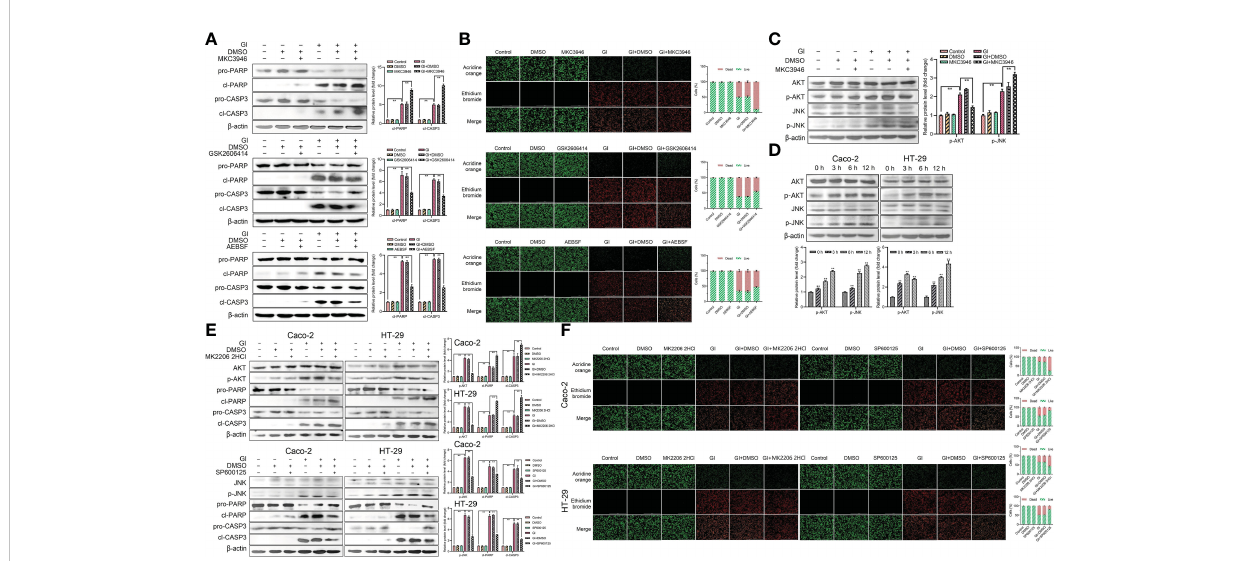
FIGURE 7 Host cell apoptosis was regulated by Giardia exposure via activating three UPR signaling pathways. (A) Western blot analysis was used to measure the protein levels of cleaved CASP3 and cleaved PARP in Caco-2 cells treated with or without inhibitors accompanied by Giardia exposure for 6 h; IRE1 inhibitor (MKC3946), PERK inhibitor (GSK2606414) and ATF6 inhibitor (AEBSF). (B) Apoptotic effects on Caco-2 cells during Giardia exposure under application of inhibitors (MKC3946, GSK2606414 or AEBSF) as assessed by AO/EB staining (n = 3 wells/group, scale bar = 1000 m m). The fl uorescence intensity was quanti fi ed using Image J. Under treatment of the combination of IRE1 inhibitor MKC3946 with Giardia in Caco-2 cells, (C) western blot analysis was used to measure the phosphorylation levels of AKT and JNK. (D) The phosphorylation levels of AKT and JNK were detected by western blotting in Caco-2 and HT-29 cells with Giardia exposure for 0, 3, 6, 12 h. Under treatment of the combination of Giardia with AKT inhibitor MKC2206 2HCl or JNK inhibitor SP600125, (E) the expression levels of cleaved CASP3 and cleaved PARP in Caco-2 and HT-29 cells were detected by western blot analysis, (F) AO/EB staining was used to detect cell apoptosis. The fl uorescence intensity was quanti fi ed using Image J. All experiments were repeated at least three times. (A, C – E) The results of western blot analyses were normalized against the level of b -actin. Data were presented as mean ± SD (n = 3). * p < 0.05, ** p < 0.01 versus relative control group. (A – F) Representative pictures are shown. Gl, Giardia